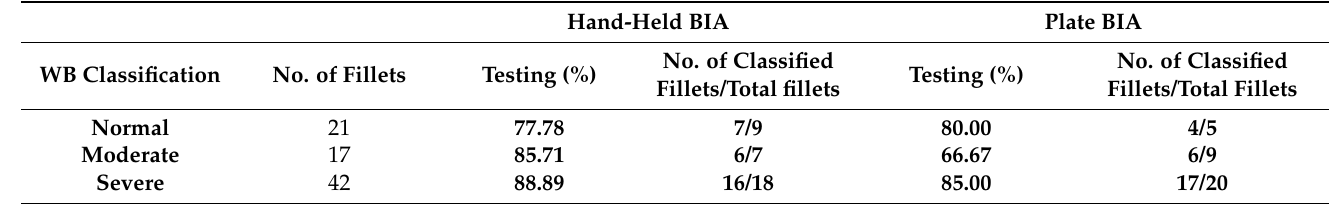
Table 4. Summary table of classification accuracies for hand-held BIA and plate BIA setup for normal, moderate, and severe woody chicken breast fillets using SVM